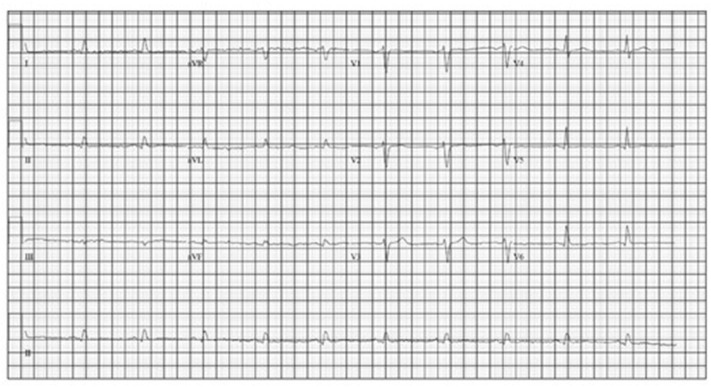
Second EKG (4/14/19).